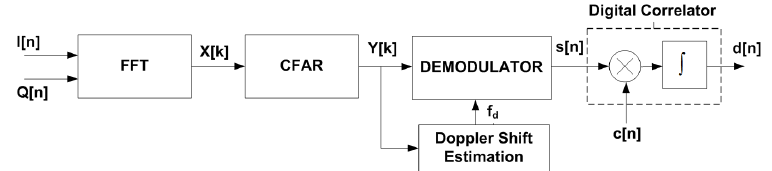
Figure 10. Block diagram of the despreading